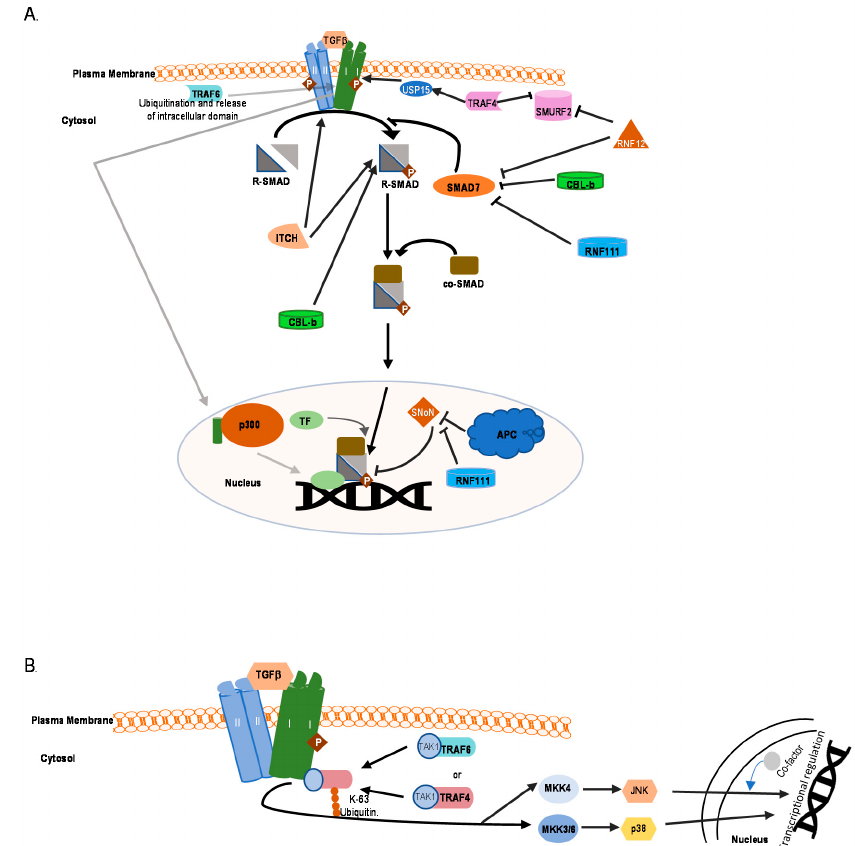
Figure 5. Schematic representation of positive regulation of TGF β signaling with major E3 ubiquitin ligases and regulation of non-SMAD signaling by TRAF4 or TRAF6 ubiquitin ligases. T β RI and T β RII are indicated as I and II. ( A ) Positive regulation of TGF β signaling by different E3 ligases. TRAF6 causes ubiquitination and release of the intracellular domain of T β RI, which translocates to the nucleus, associates with p300, and affects transcription of genes. RNF111/ARKADIA inhibits the negative regulator of TGF β induced transcription SNoN. ( B ) Regulation of JNK/p38 signaling by TRAF4 or TRAF6 E3 ligases.